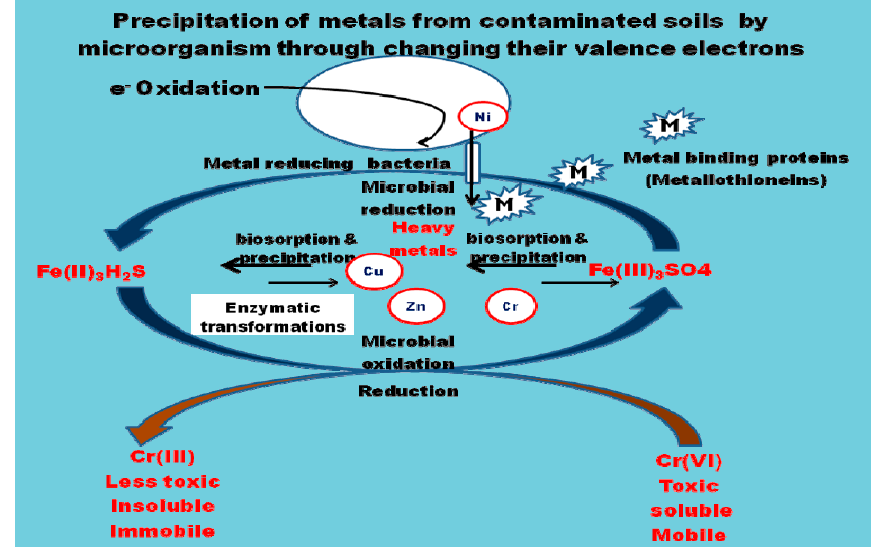
Figure 1. Mechanisms of removal of heavy metals from contaminated soils by microorganims through the processes of precipitation, biosorption via sequestration by intracellular metal binding proteins (metallothioneins) and conversion of metals to innocous forms by enzymes (enzymatic transformation). Figure was not cited.